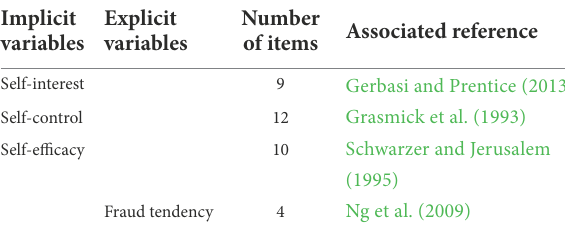
TABLE 1 Questionnaire items under Implicit Variables and Observable